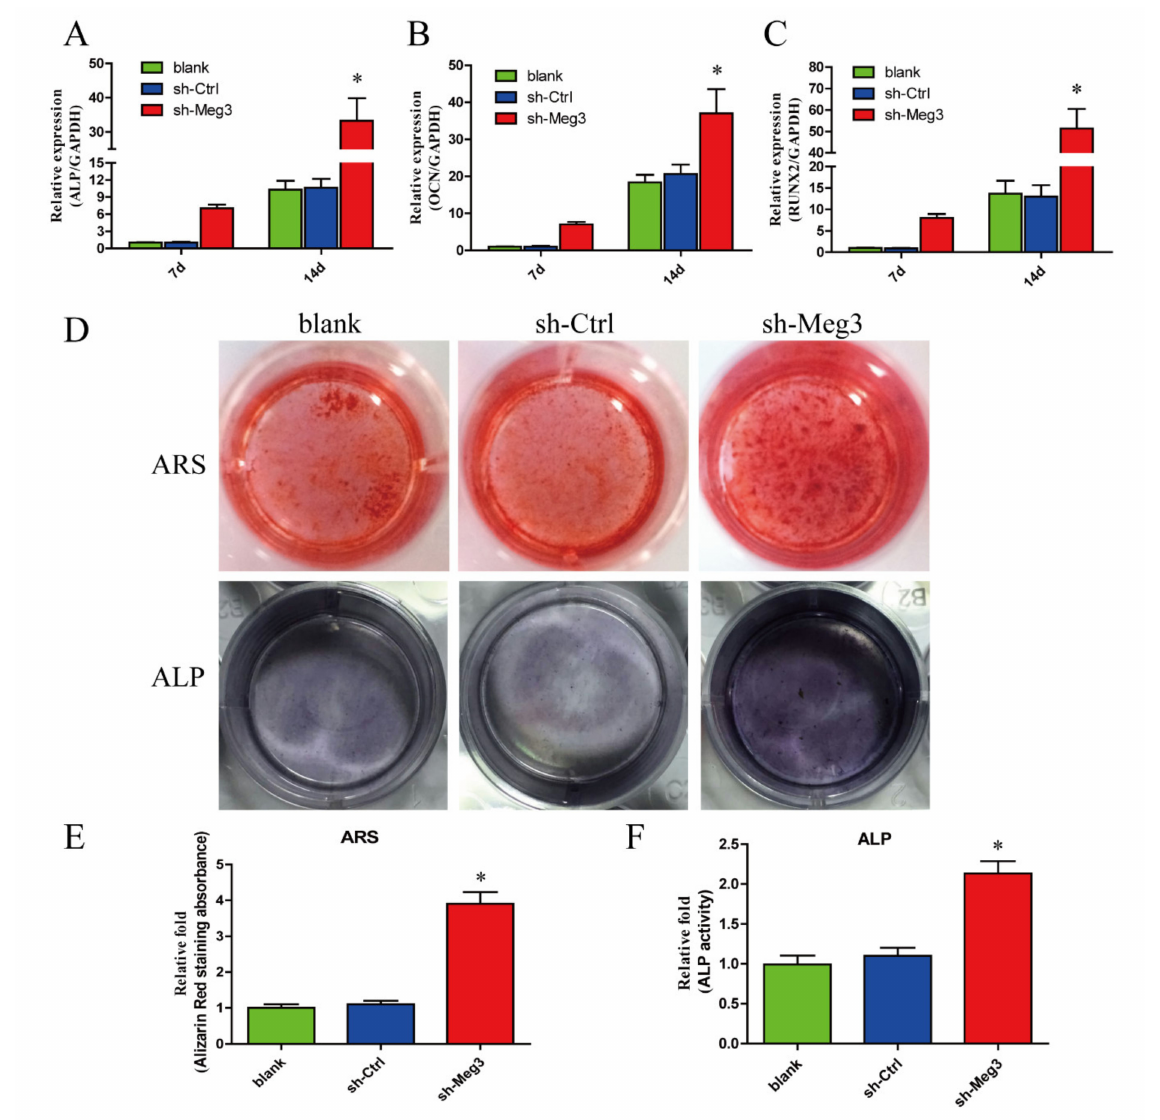
Figure 2. MEG3 knockdown promoted osteogenic differentiation of BMSCs. ( A ) Bar graph shows the qRT-PCR analysis of ALP expression at days 7 and 14 of osteogenic differentiation. ( B ) Bar graph shows the qRT-PCR analysis of OCN expression at days 7 and 14 of osteogenic differentiation. ( C ) Bar graph shows the qRT-PCR analysis of RUNX2 expression at days 7 and 14 of osteogenic differentiation. ( D ) ARS and ALP staining in the blank, sh-ctrl and sh-Meg3 groups at day 14 of osteogenic differentiation. ( E ) Alizarin red staining area in the blank, sh-ctrl and sh-Meg3 groups determined by measuring the absorbance at 560 nm. ( F ) ALP activity in the blank, sh-ctrl and sh-Meg3 groups at day 14 of osteogenic differentiation. Data are presented as mean ± SD. * p < 0.05 versus sh-Ctrl group ( n =